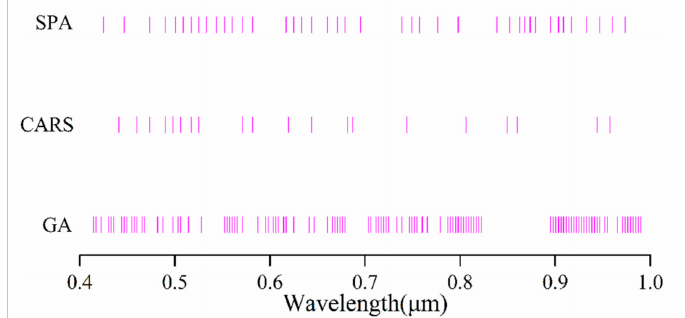
Figure 11. Waveband selection